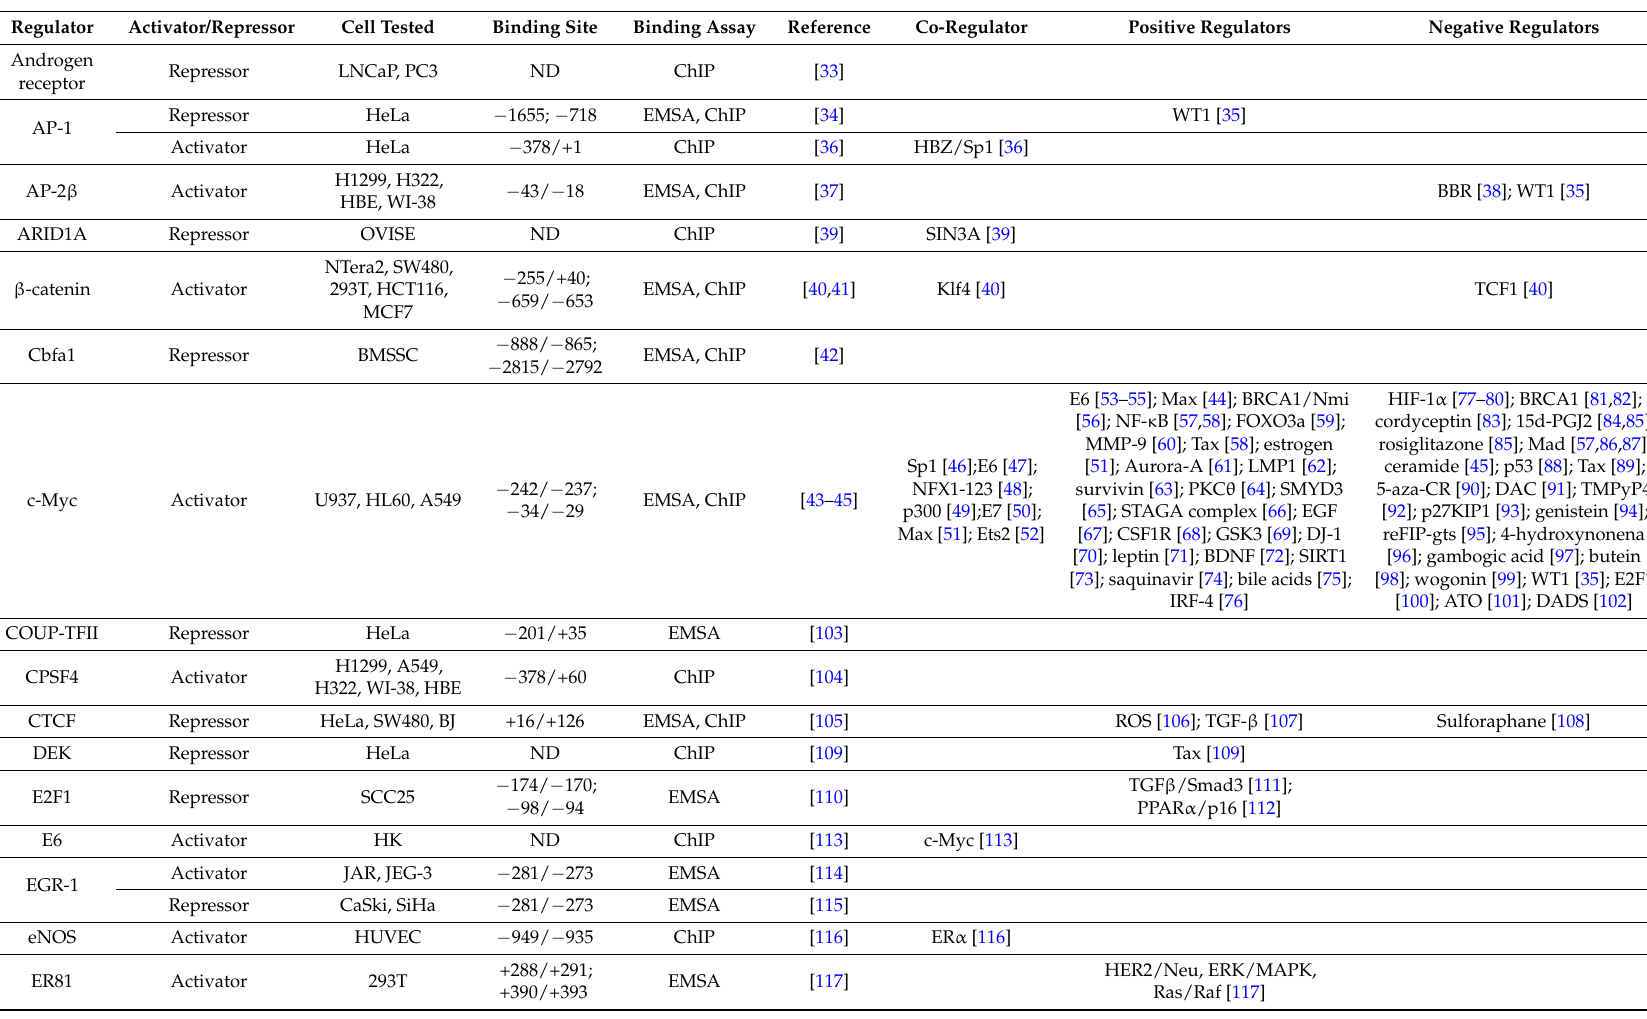
Table 1. List of factors reported to bind to human Telomerase Reverse Transcriptase ( hTERT ) promoter and regulate its